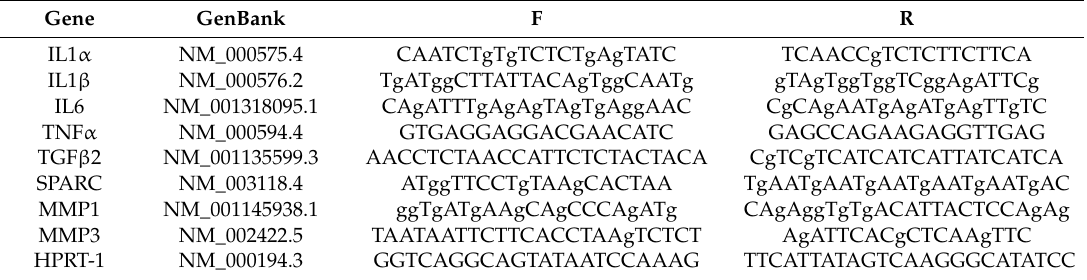
Table 1. Primer sequences used for real-time quantitative polymerase chain reaction